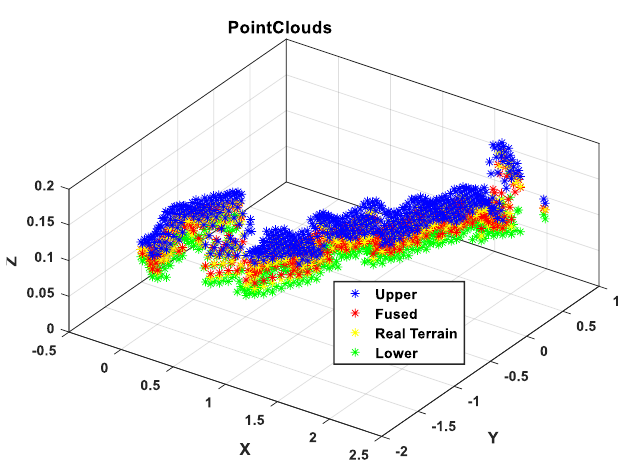
Figure 23. Terrain mapping results profile.